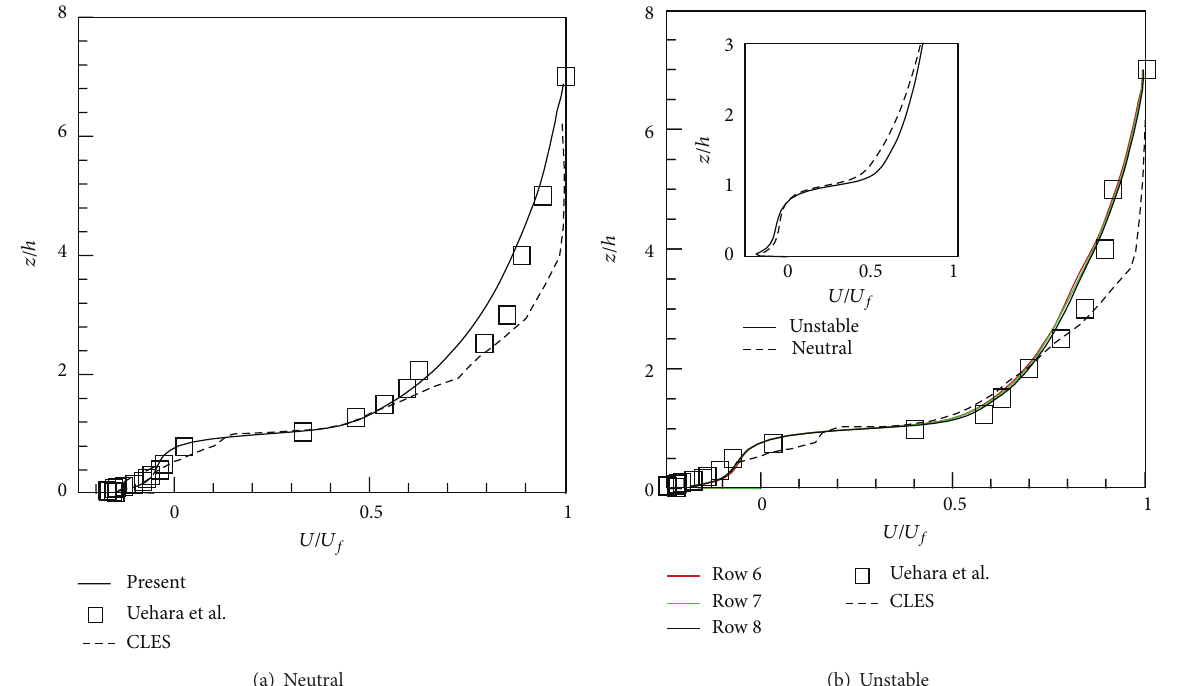
Figure 3: Vertical profiles of mean streamwise velocity normalized with free stream velocity 𝑈 𝑓 for both neutral and unstable cases.